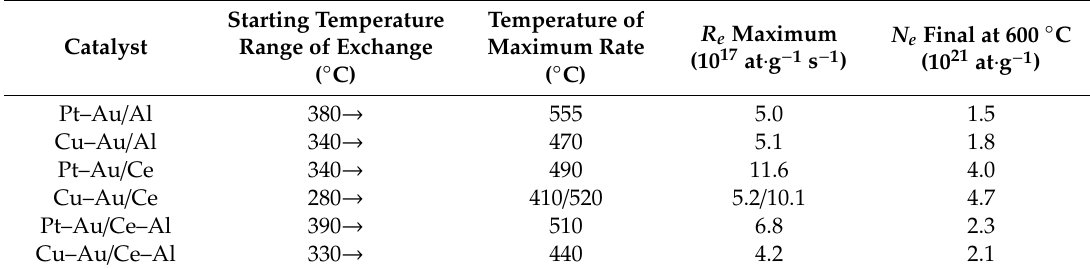
Table 4. Results of the thermally programmed isotopic exchange experiments for all the prepared catalysts ( R e is the rate of oxygen exchange, and N e is the number of exchanged